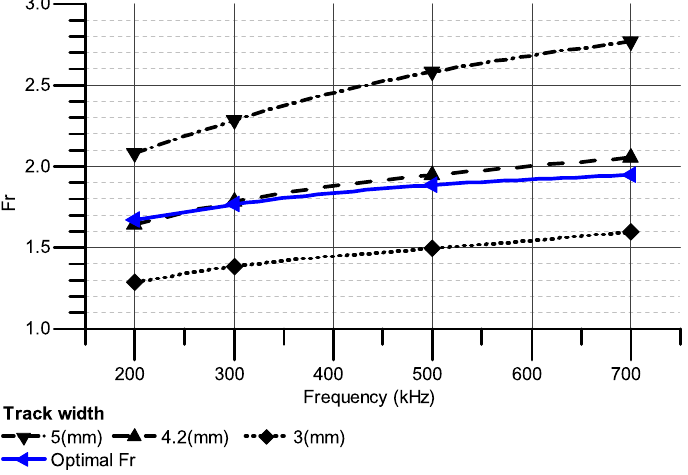
Figure 19. Group-2 measured R AC / R DC